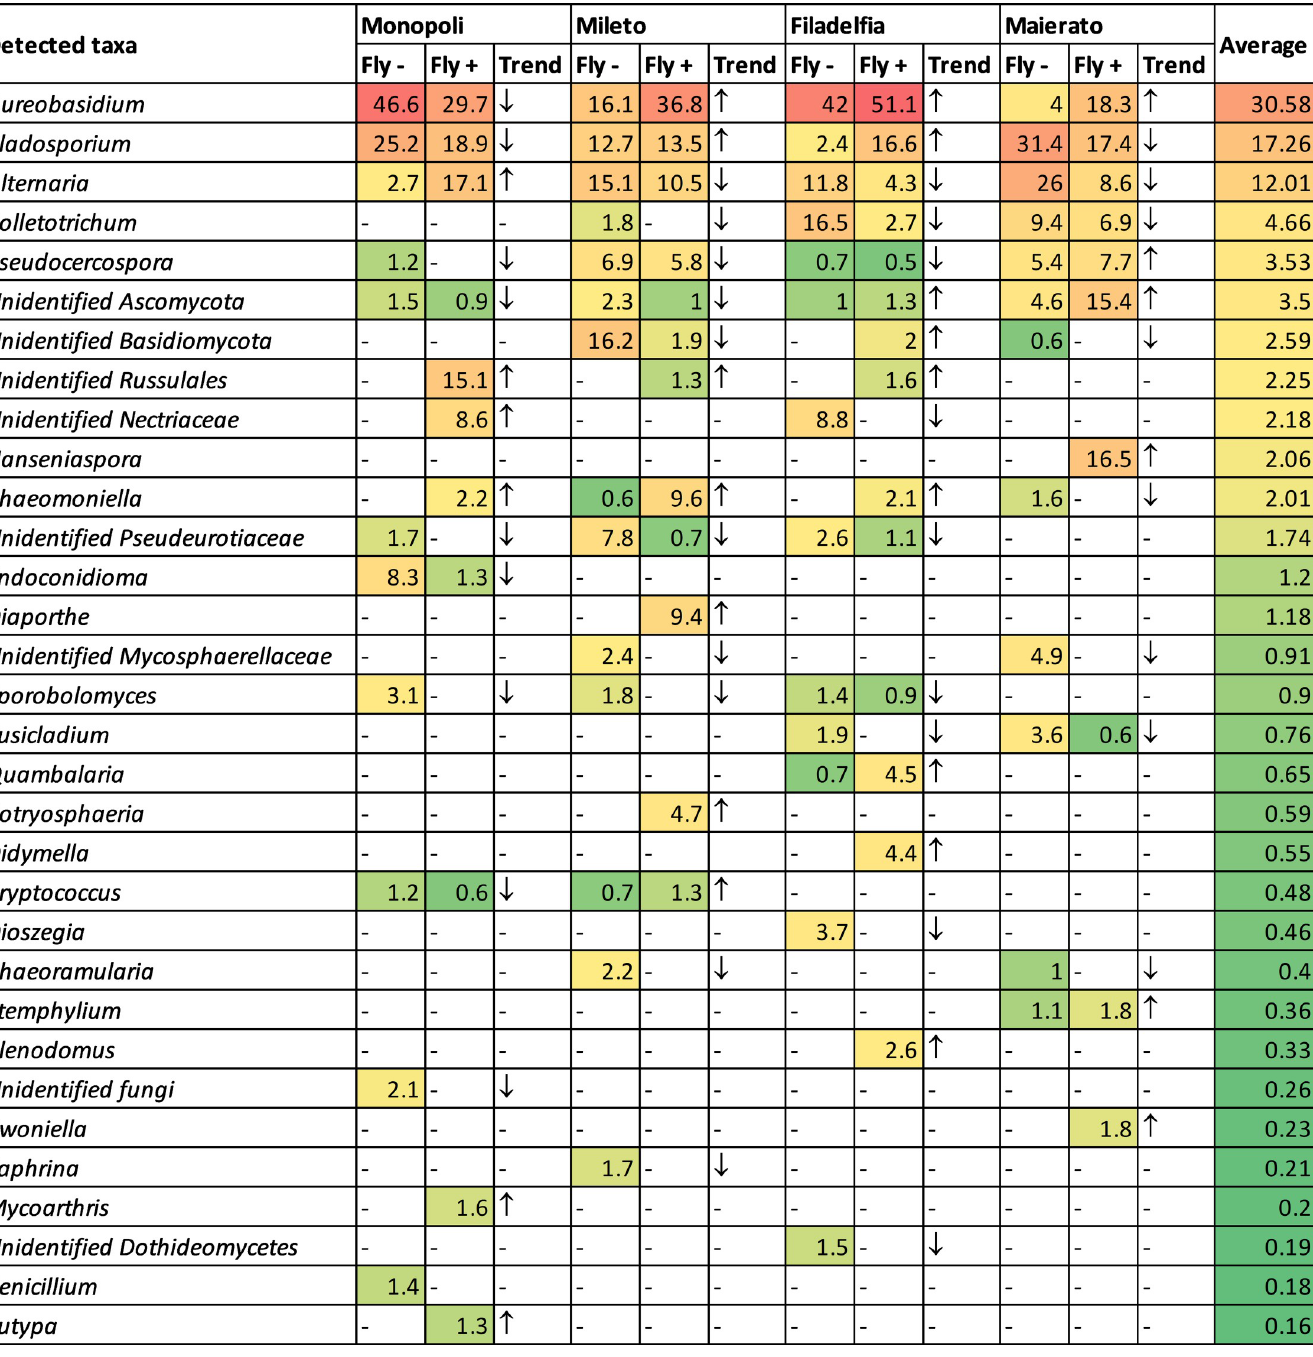
Fig 5. Heatmap highlighting the differences in the taxa detected in infested (Fly +) and non-infested (Fly -) olives from four different localities with an overall relative abundance of at least 0.16%. Arrows indicate the trend of each taxa in infested olives as compared to the non-infested ones.